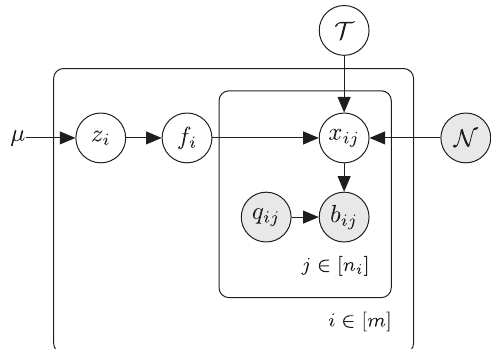
Fig. 6 Graphical model used for the computation of the likelihood of a locus across multiple samples having a somatic SNV (single-nucleotide variant), as well as the corresponding tumor allele T . Different loci are analyzed independently. We consider m samples, with n i reads for each sample mapping to the considered locus. μ is the somatic mutation rate; z i is the latent binary indicator for sample i carrying the somatic SNV; T and N are the tumor and normal allele, respectively; x ij is the error-free base; b ij is the observed base; and q ij is the sequencing error